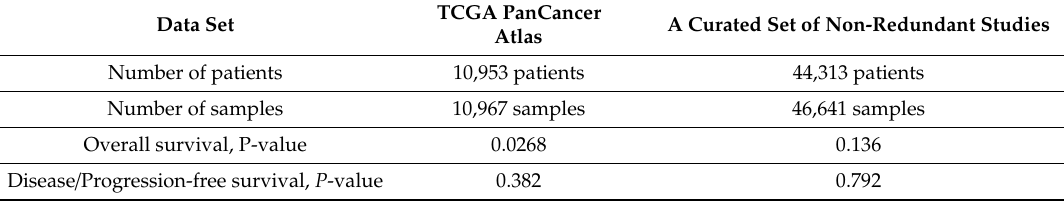
Figure 7. The clinical significance of SLC6A3 / DAT in cancer. ( A ) Genetic alteration of DAT / SLC6A3 from a combined study (44,313 patients / 46,641 samples). ( B ) Overall survival Kaplan-Meier estimate of cases with or without DAT / SLC6A3 alteration(s). Data were obtained from TCGA PanCancer Atlas (10,953 patients / 10,967 samples). Table 1. Correlation of DAT / SLC6A3 genetic alterations with a poor prognosis of cancer